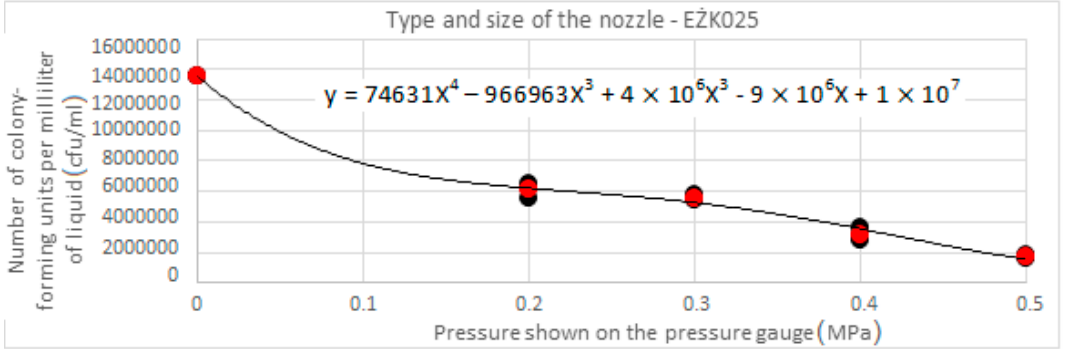
Figure 2. The influence of pressure on survival of cfu/mL of liquid for E Ż K02. The vertical axis shows the cfu/mL values, while the horizontal axis shows the pressure (MPa) values set in the throttling valve and read in manometers.